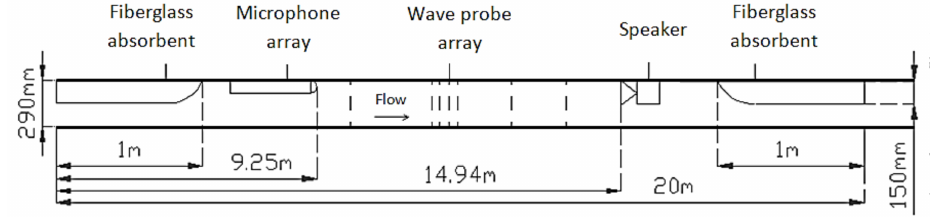
Figure 1. Pipe arrangement with presence of wave probe and microphone arrays, speaker, and fiberglass absorbents. Not to scale.